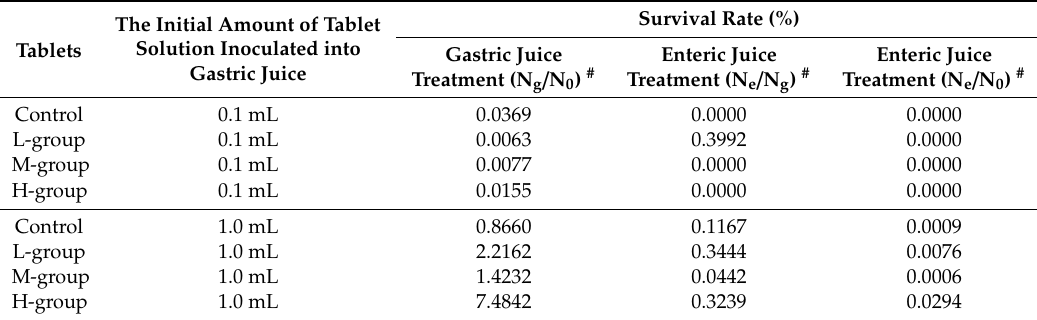
Table 5. The survival rate of lactobacilli cells after contact with gastric juice for 30 min followed